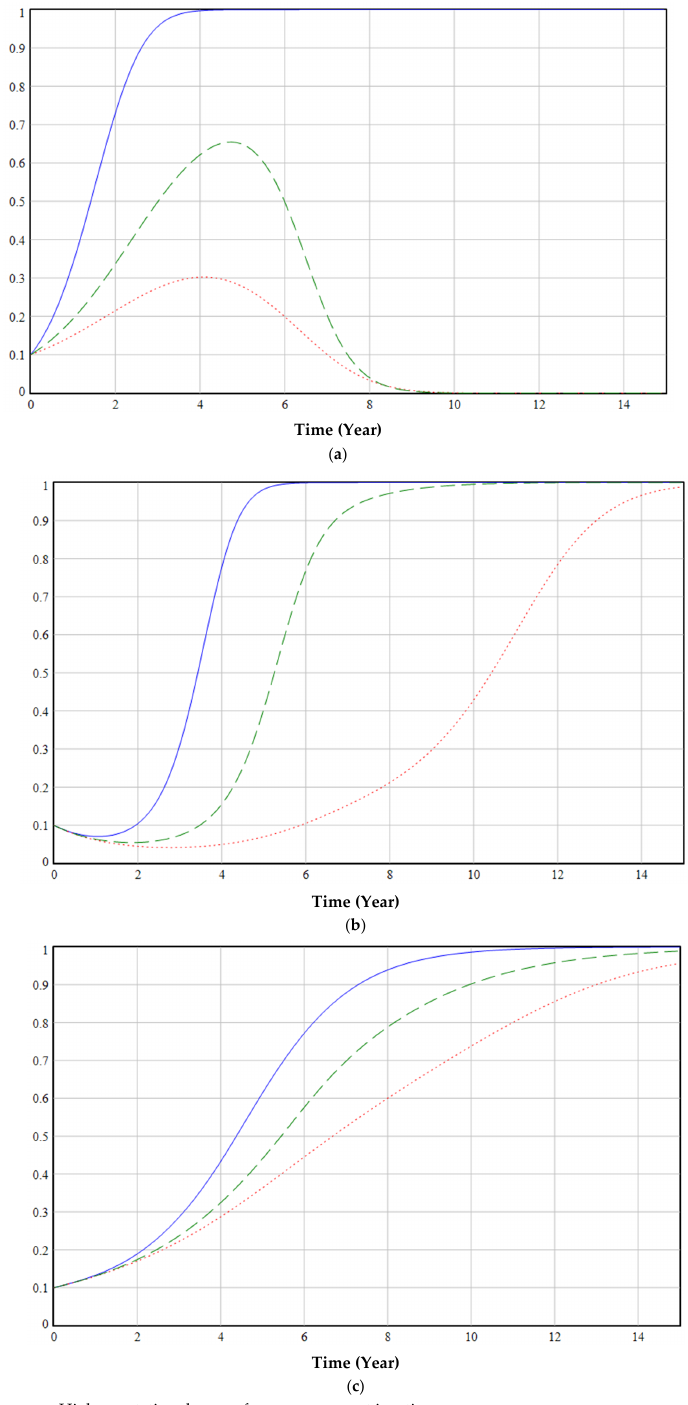
Figure 13. The effect of H on decisions of government ( a ), enterprises ( b ), and medical institutions ( c ).